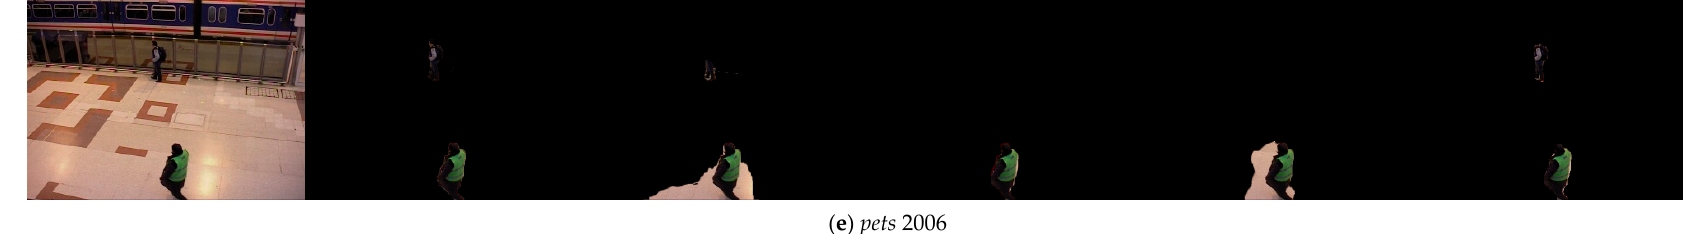
Figure 5. Experimental results of final pixel level labeling on the cars 3 (row 1), cars 4 (row 2), people 1 (row 3), people 2 (row 4), and pets 2006 (row 5) sequences. (Column 1) Input image. (Column 2) Ground truth. (Column 3) Sheikh et al. [22]. (Column 4) Zhu et al. [26]. (Column 5) Chiranjoy et al. [31]. (Column 6) Our algorithm. Table 2. Quantitative evaluation of pixel level labeling.